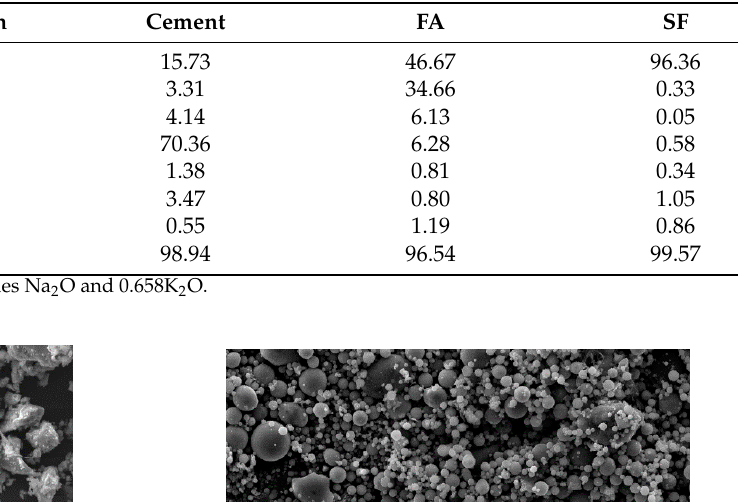
Table 2. The mix proportions of the mortars. Sample